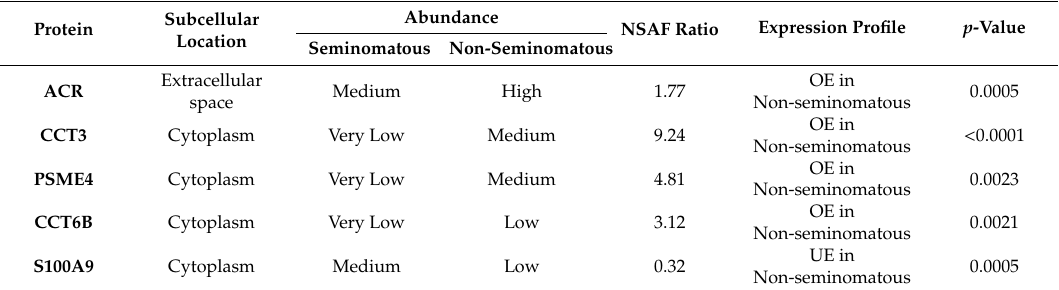
Table 3. Proteomic data of the di ff erentially expressed proteins (DEPs) identified in the spermatozoa samples of patients with seminomatous and non-seminomatous testicular germ cell tumors before cancer therapy, which were selected for validation by western blotting.